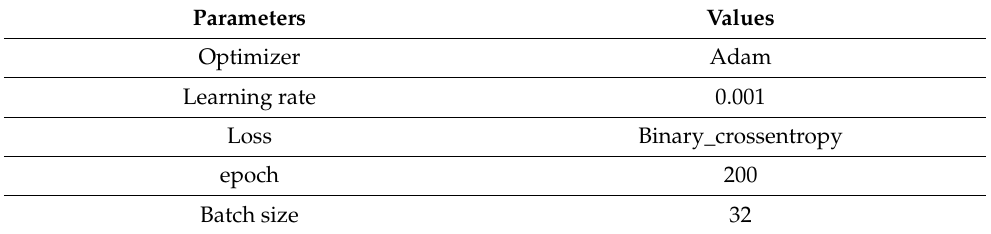
Table 3. Fine-tuned